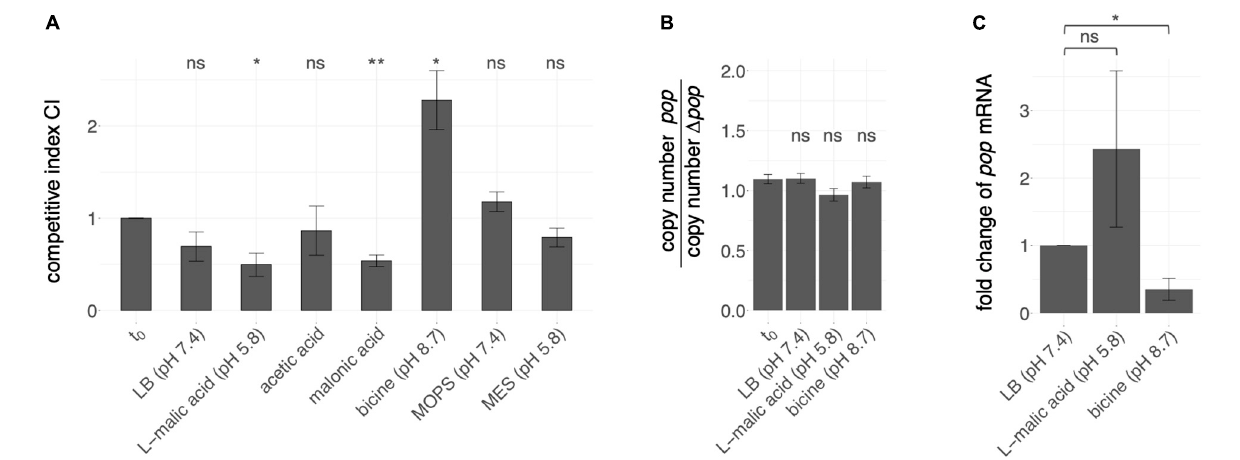
FIGURE 4 | Effect of pop expression in various pH ranges. (A) Overexpression phenotypes of pop in competitive growth assays. Competitive growth of EHEC while overexpressing either intact (pBAD+ pop ) or translationally arrested pop (pBAD+ (cid:49) pop ) was conducted in conditions as indicated, i.e., LB medium supplemented with an organic acid or a biological buffer. Mean competitive indices CI are given as the ratio of relative abundance of cells expressing mutant or wild type plasmid measured by peak heights, i.e., fluorescence intensities in sequencing electropherograms at the mutated positions, in different culture conditions regarding the input ratio t 0 . Error bars indicate standard deviations. Statistical significant differences of the CI (tested with paired t -test) before and after growth is indicated ( * p ≤ 0.05; ** p ≤ 0.01; ns, not significant). (B) Copy number estimation for both plasmids. Genomic and plasmid DNA of EHEC transformants (pBAD+pop and pBAD+ (cid:49) pop ) separately grown in the indicated growth conditions was relatively quantified by qPCR of a genome section ( cysG -gene) and plasmid ( bla -gene) specific gene segment. The mean ratios of quantification cycle differences [ (cid:49) Cq(Cq( cysG )-Cq( bla )) = copy number] for the two transformants of three biological replicates are given. Error bars indicate standard deviations. No statistical significant ratio difference before and after growth was detected (tested with paired t -test; ns, not significant, p -value > 0.05) (C) pop expression measured by quantitative PCR (qPCR). Fold change of pop mRNA has been calculated based on (cid:49) Cq (difference in cycles of quantification) values of pop mRNA and 16S rRNA of EHEC grown to early exponential phase (OD 600 = 0.3) in LB, LB + L-malic acid or bicine-buffered LB medium. Mean values and standard deviations of three biological replicates are shown. Statistical significance was tested with one-tailed Welch two sample t -test ( * p ≤ 0.05; ns, not